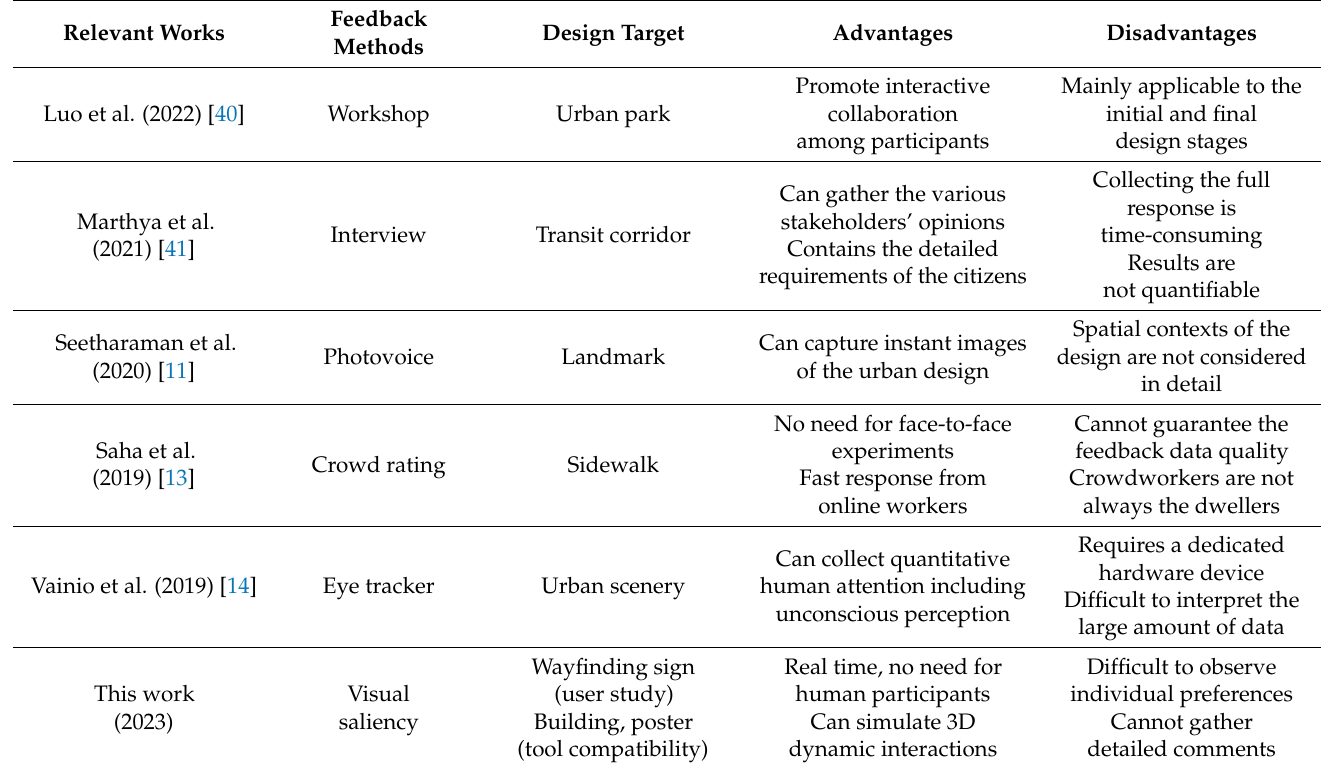
Table 1. Advantages and disadvantages of the proposed method and previous methods for urban design